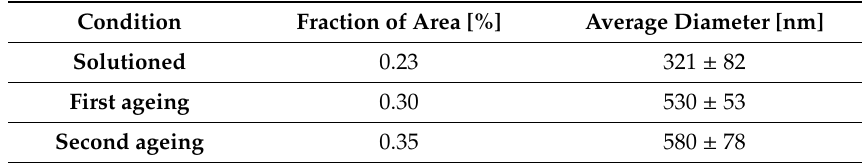
Figure 13. EDS spectra comparing the matrix (solid black line), Mo carbides inside a grain (black dotted line) and Cr carbides at the grain boundary (solid gray line). Table 4. Evolution of fraction of area occupied by carbides and their average diameter in HT samples from solutioning to second aging.